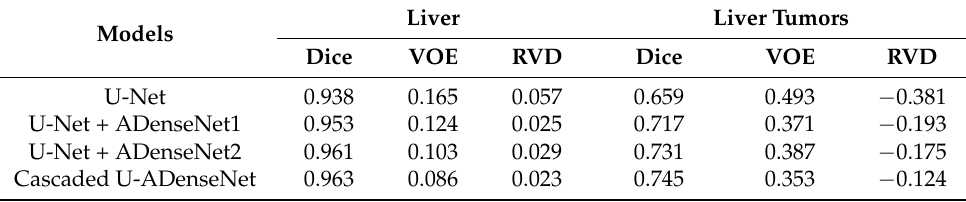
Table 1. Segmentation results of the liver and liver tumors on ablation analysis.